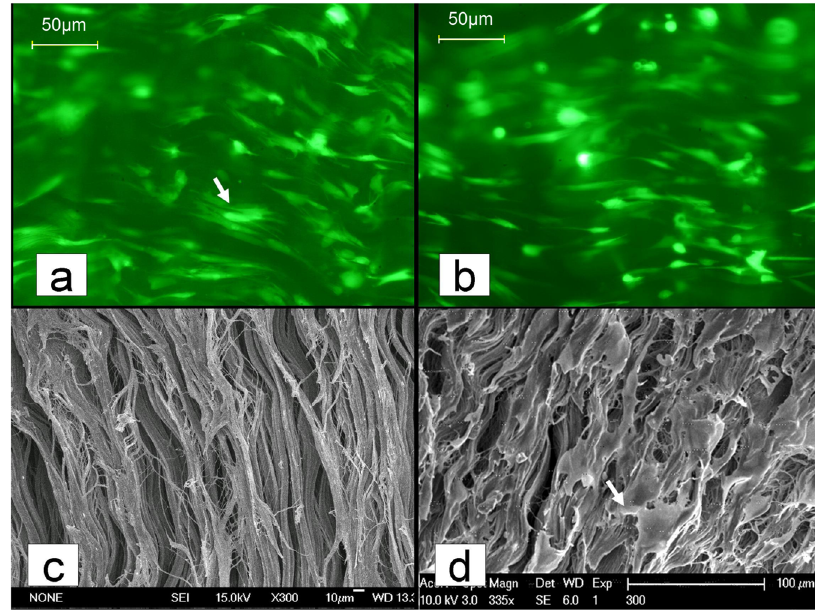
Fig. 10 Fluorescence microscopy and scanning electron microscopy of GFP- tagged fi broblasts on specimens. a Cocultures at 24 h show more fi broblasts attached to the acellular aponeurosis-discission ligament (AADL) surface (as indicated by the white arrow on the green fl uorescent display, magni fi cation ×400); b the fi broblast density in cocultures incubated for 72 h did not change signi fi cantly (magni fi cation ×400); c AADL surface before coculture with cells (magni fi cation ×300); d cocultures at 72 h show more seeded cells (indicated by the white arrow) attached to the AADL surface (magni fi cation